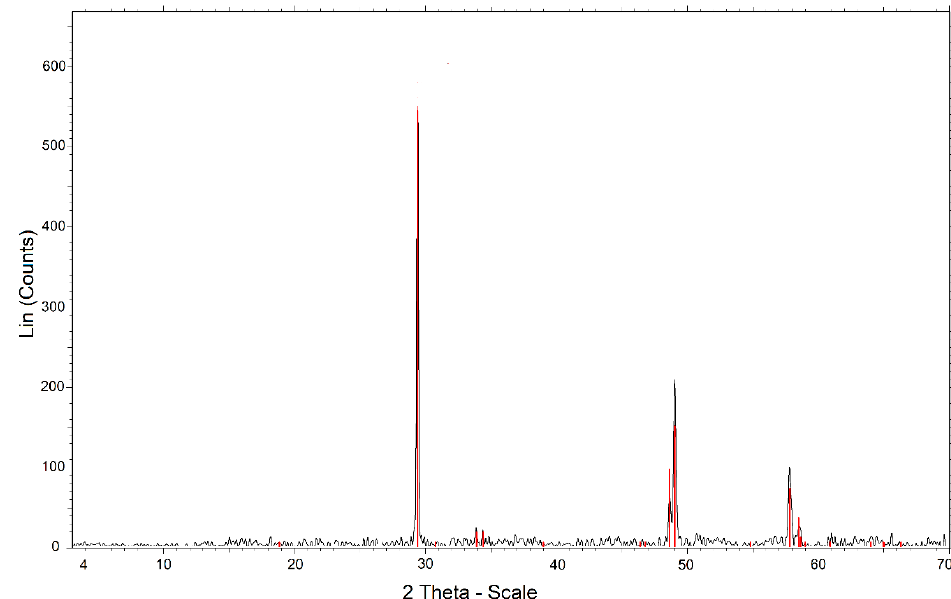
Figure 1. X-ray di ff ractogram for the chalcopyrite. Figure 1. X-ray diffractogram for the chalcopyrite.